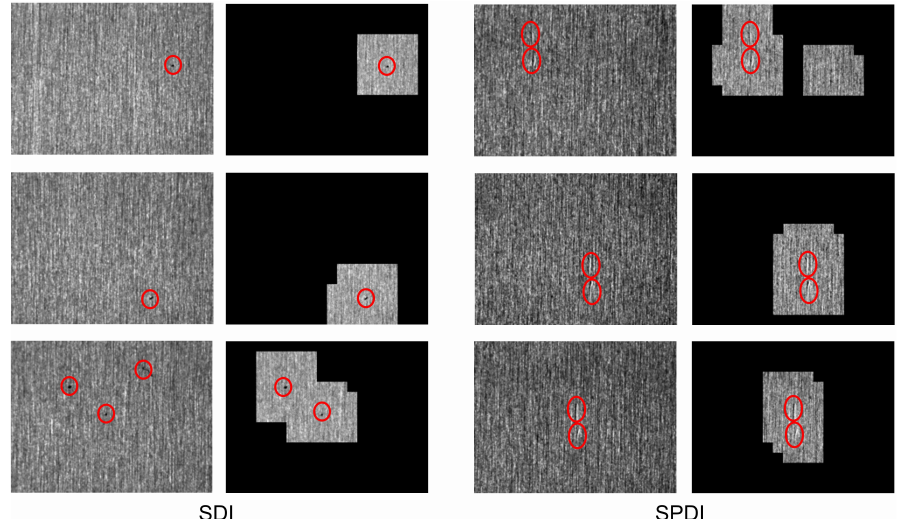
Figure 16. The examples of detection results in a micro-surface defect database. The red ellipse marks the location of the defect. The left image is the image to be detected, and the right image is the detection result. Our model judges that areas without defects are covered with black images.